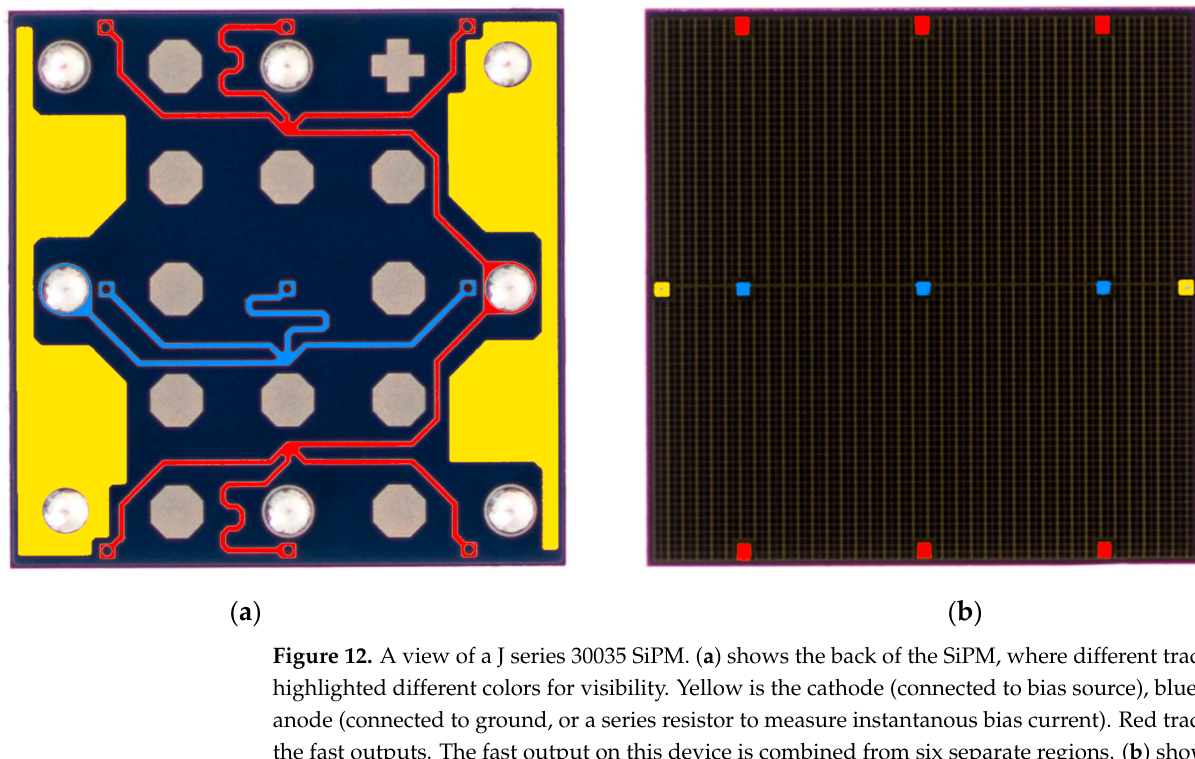
Figure 12. A view of a J series 30035 SiPM. ( a ) shows the back of the SiPM, where different traces are highlighted different colors for visibility. Yellow is the cathode (connected to bias source), blue is the anode (connected to ground, or a series resistor to measure instantanous bias current). Red traces are the fast outputs. The fast output on this device is combined from six separate regions. ( b ) shows the top of the SiPM, where the through-silicon via processes connect to the traces on the rear. (Adapted from [28]).